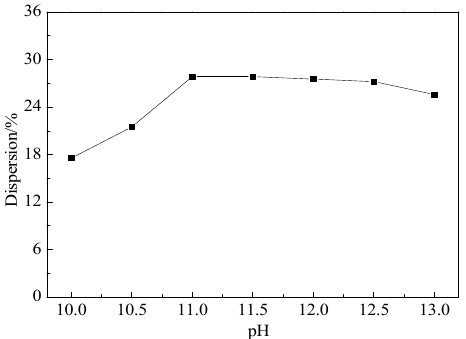
Figure 7. Dispersion rate at different slurry pH.